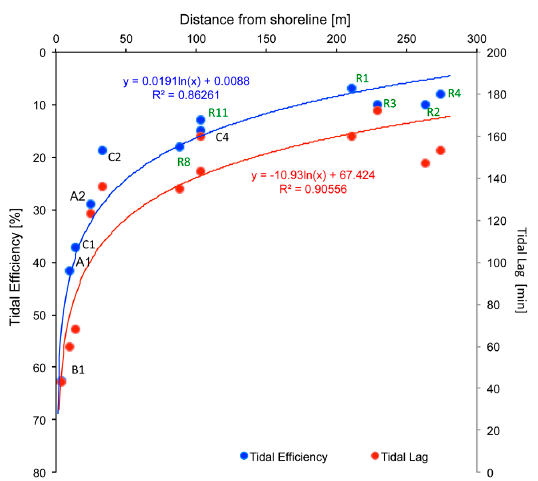
Figure 4. Tidal efficiency and tidal lag calculations for groundwater wells. Groundwater well locations shown in Figure 1. Data for groundwater wells R1–R11 (green) were published by Gingerich, 1992 and normalized to 3 m depth using a linear relationship.